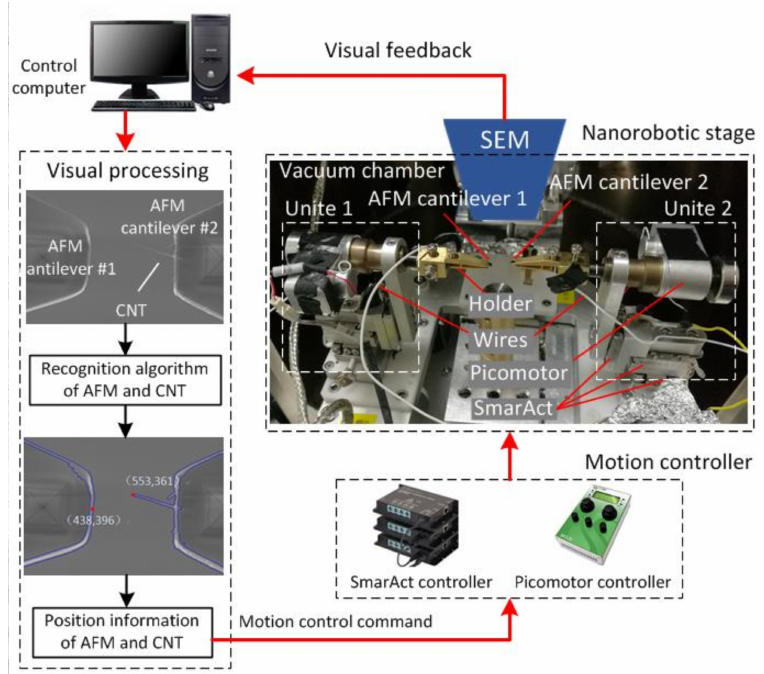
Figure 1. Architecture of nanorobotic manipulation system vision-based